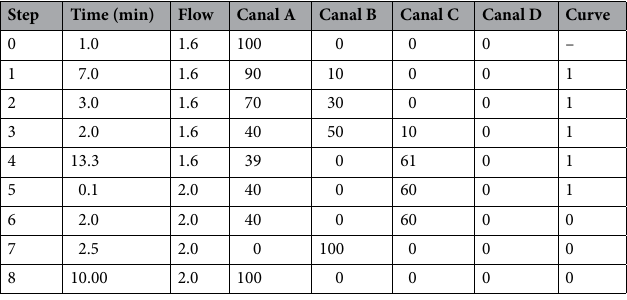
Table 2. Gradient profile for separation of lipid